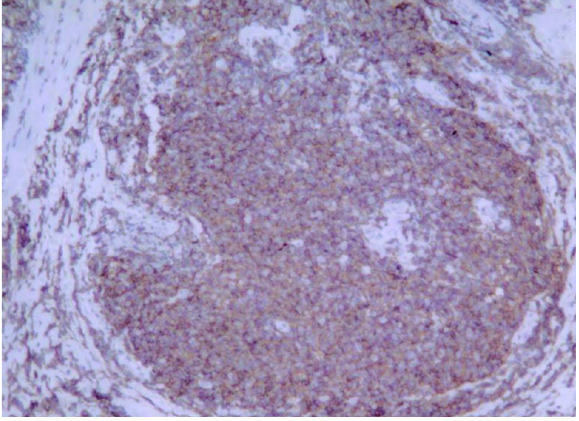
Figure 3 – Immunohistochemical positivity to CD20 (X400).